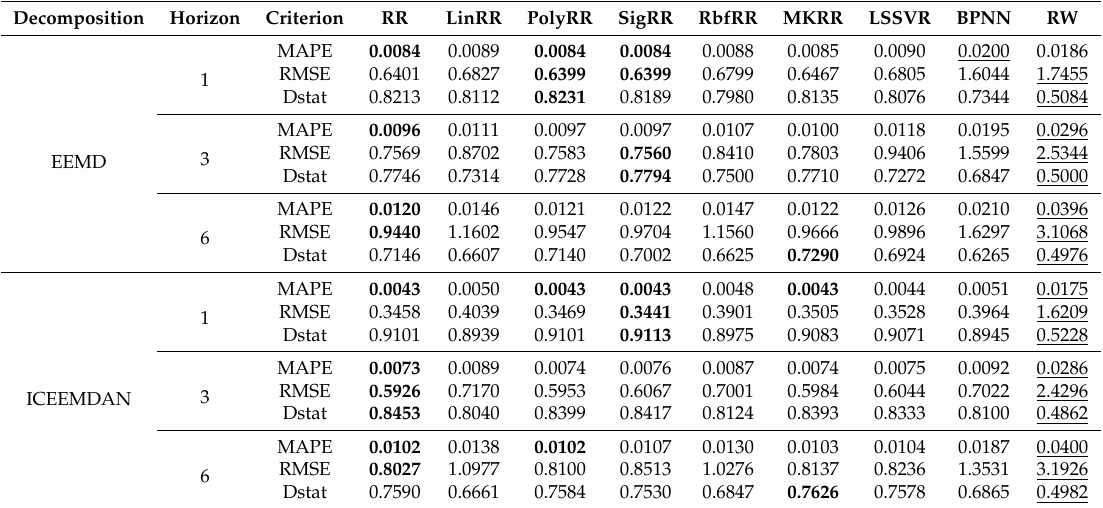
Table 4. Results of ensemble